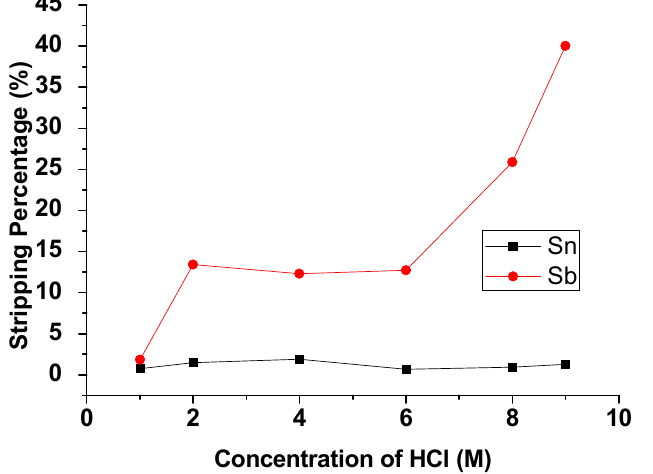
Figure 6. Stripping percentage of Sn and Sb at different concentrations of HCl. O/A ratio = 1, reaction time = 5 min.